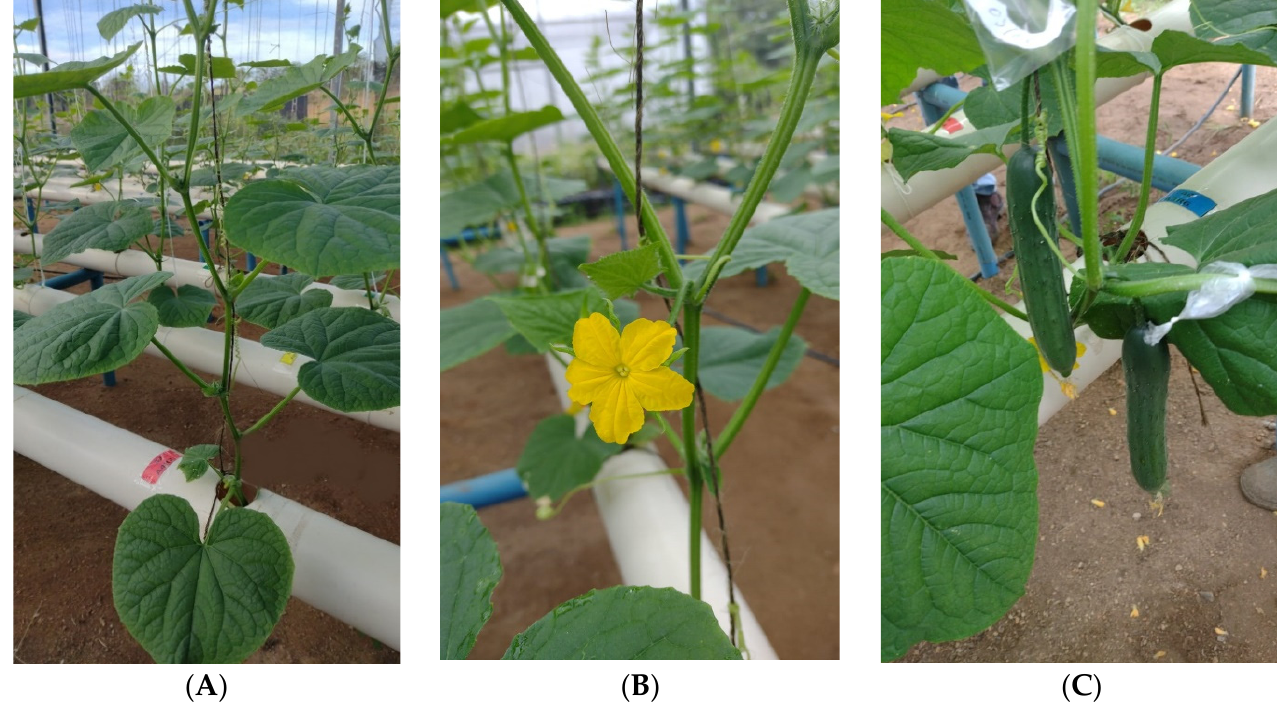
Figure 3. Cultivation of Japanese cucumber in NFT—Nutrient Film Technique hydroponic system—at different stages of development (Vegetative stage—( A ), flowering stage—( B ), and fruiting stage—( C )).